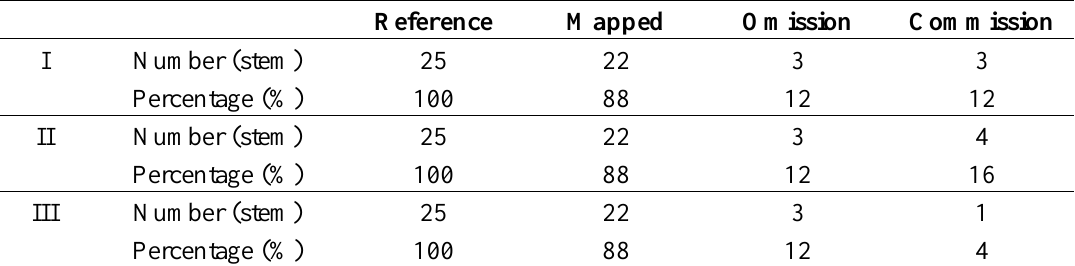
Table 1. Tree mapping accuracies of image-based point clouds.